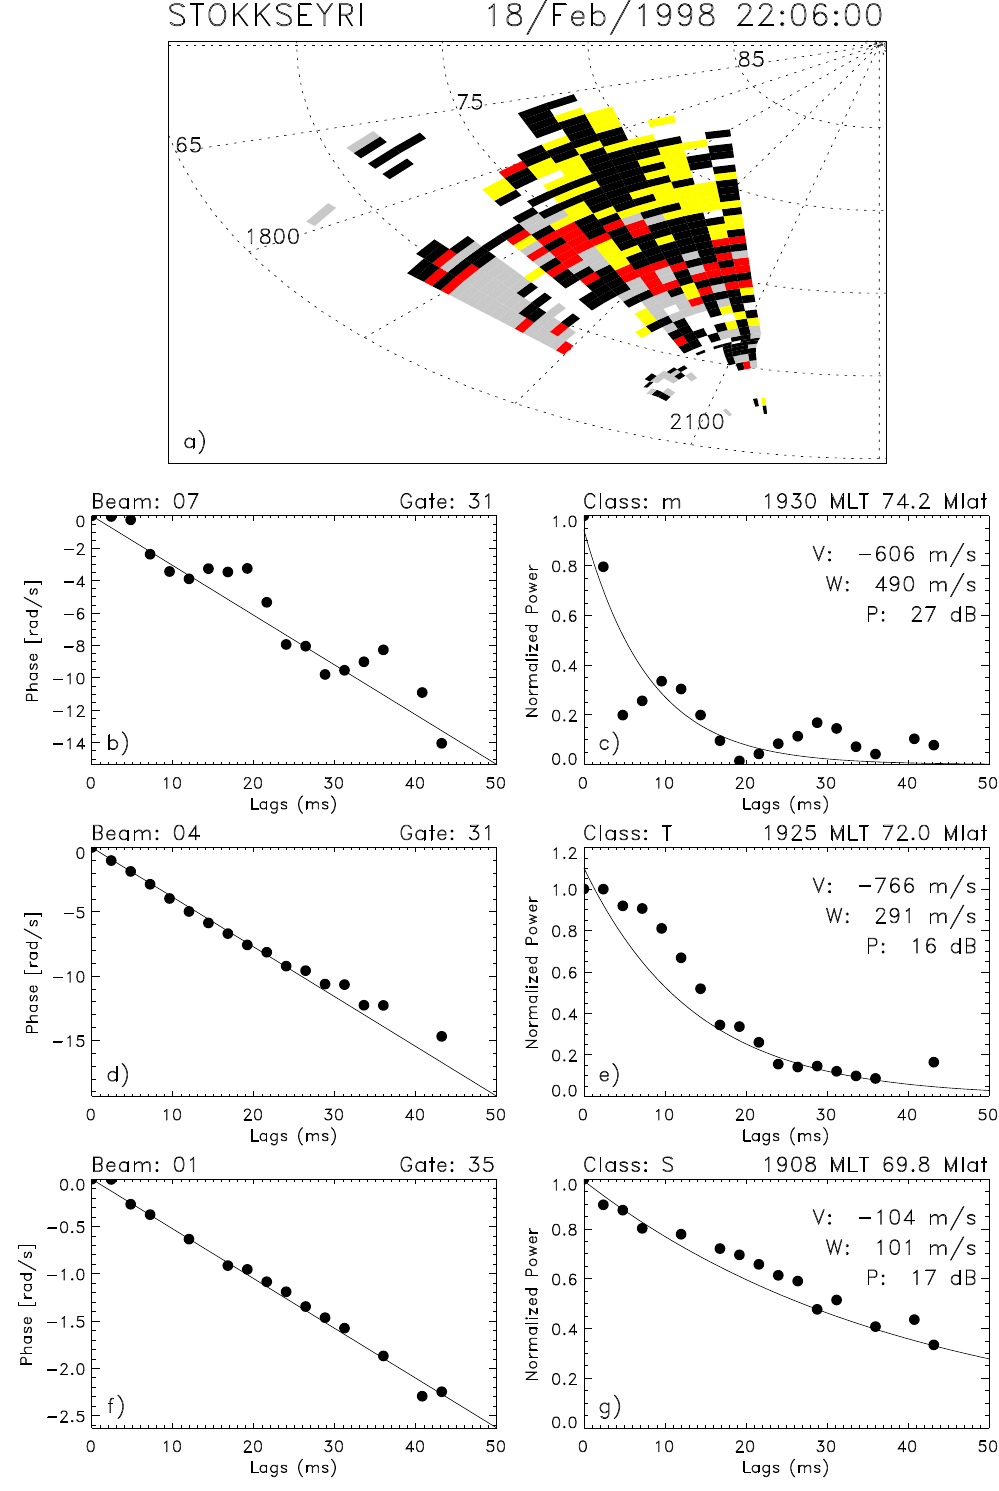
Fig. 7. (a) ACF classes observed by the Stokkseyri radar on the 18 February 1998 at 22:06UT in geomagnetic (MLT, MLAT) coordinates. Class “m”, “T” and “S” are coded in yellow, red and gray, respectively. (b) and (c) are the ACF phase and power recorded on beam 7, gate 31 during this scan. In the same way, (d) , (e) and (f) , (g) are the ACF phase and power recorded on beam 4 gate 31 and beam 1 gate 35,